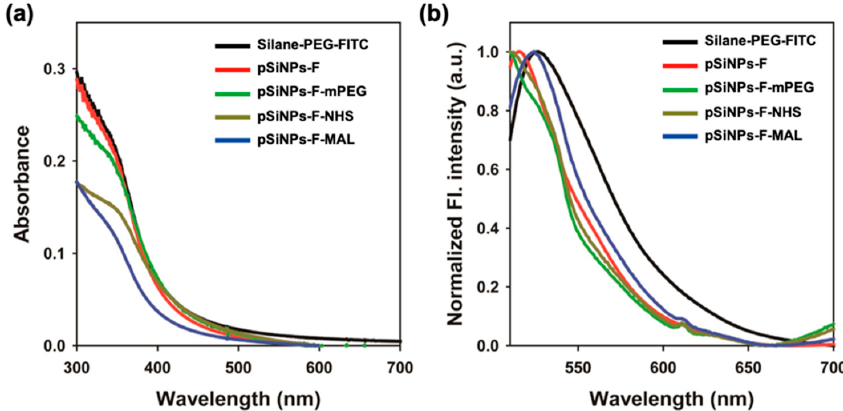
Figure 4. Attenuated total reflectance Fourier-transform infrared (ATR-FTIR) spectra of the pSiNPs-OH and its surface-functionalized samples. Symbols: υ = stretching, δ = bending, Si = peaks associated with porous silicon surface.